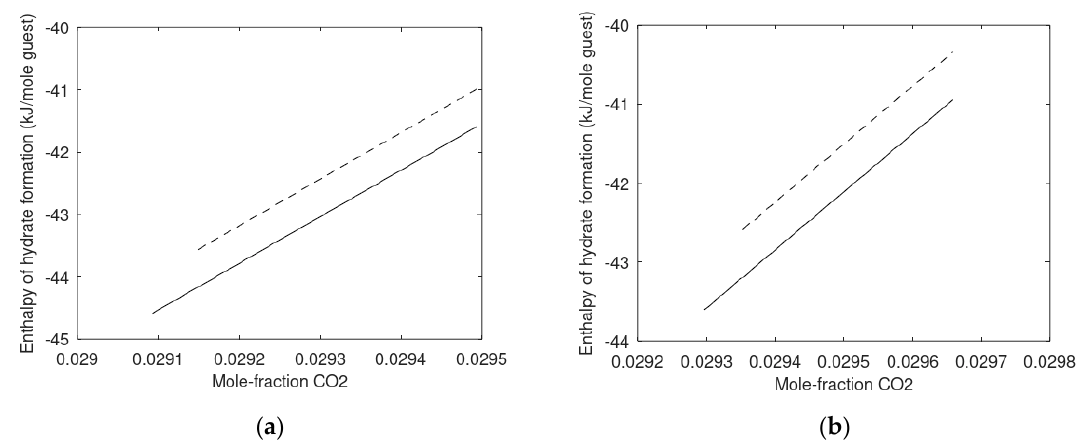
Figure 17. Enthalpy of hydrate formation from dissolved CO 2 in water. ( a ) Temperature 274 K and pressure 100 bar. Solid curve is for pure water and dashed curve is for water containing 3 mole percent ethanol. ( b ) Temperature 280 K and pressure 180 bar. Solid curve is for pure water and dashed curve is for water containing 3 mole percent ethanol.